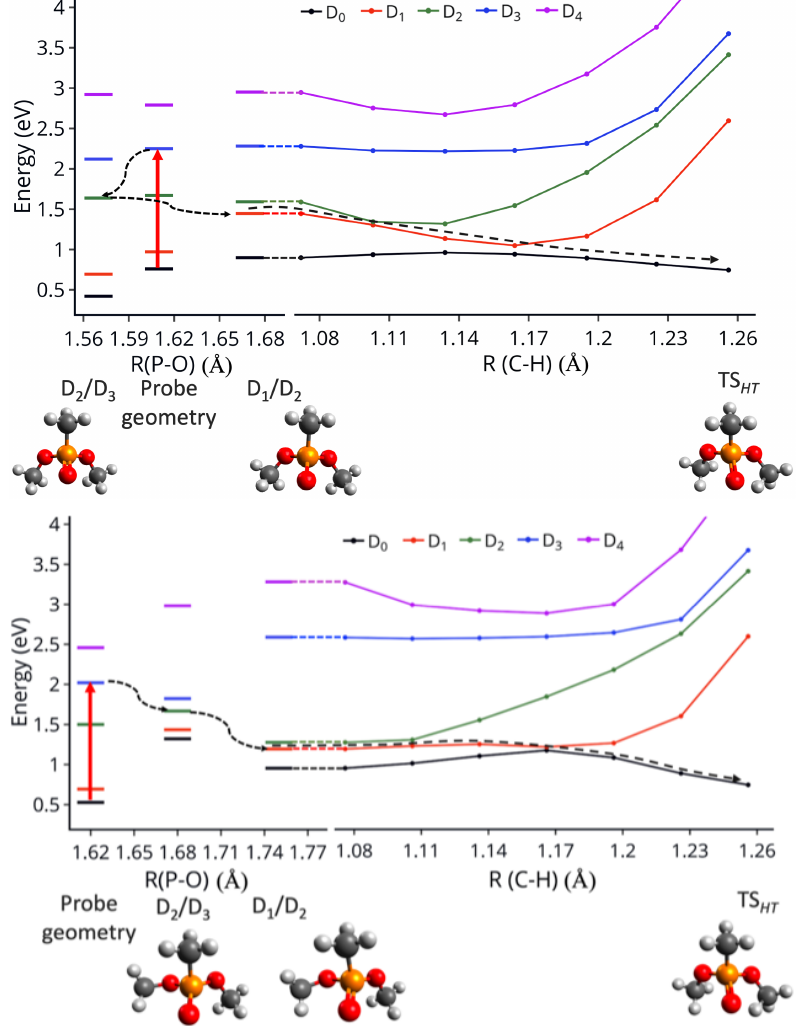
Figure 7. Top : Energies at the geometry of probe pulse excitation to D 3 ; at the CoIn D 2 /D 3 geometry and at the CoIn D 1 /D 2 geometry. Bottom : Energies along LIICs connecting the D 1 /D 2 CoIn to the transition state (TS HT ). Top plots show the energies for the C s conformer and bottom plots for the C 1 . All the calculations were done at EOM-IP-CCSD/6-311+G(d) level of